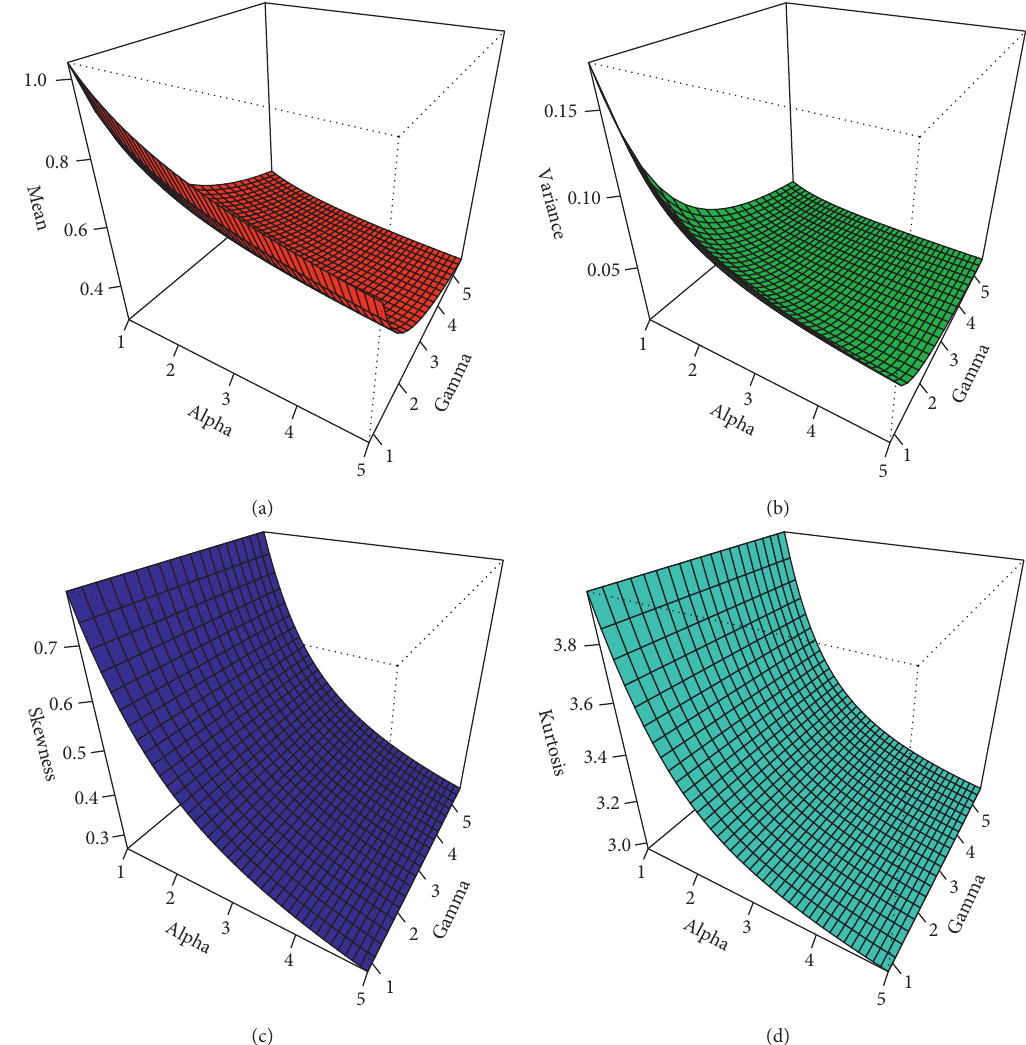
Figure 7: Plots for the mean, variance, skewness, and kurtosis of the L-Claim distribution for c � 0 . 5 and different values of α and σ